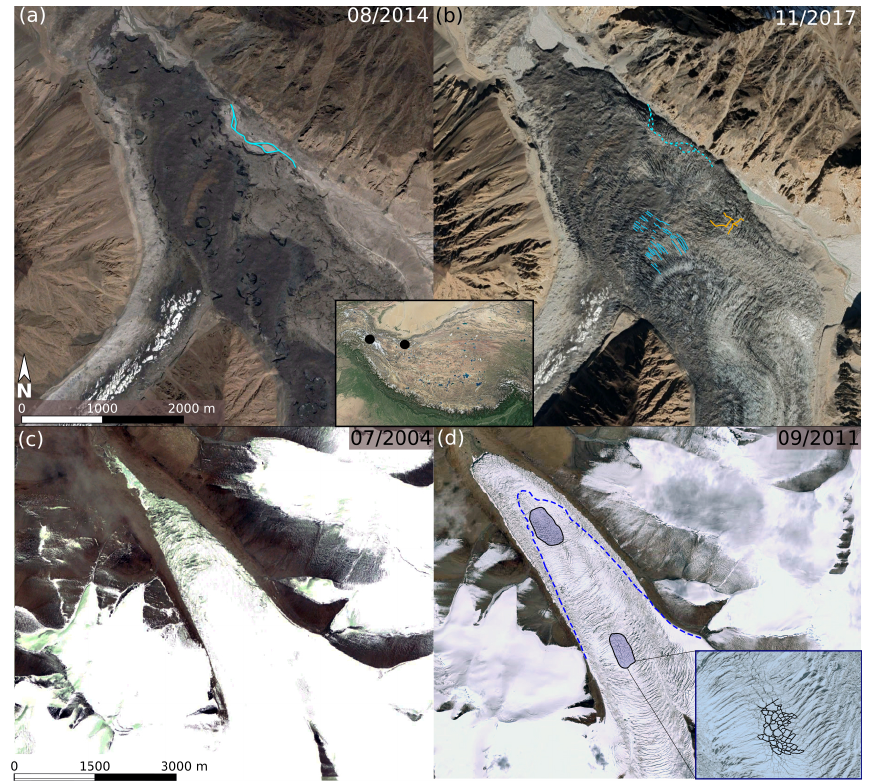
Figure 3. Google Earth imagery close-ups of surface features indicative of surges on debris-covered ( a, b : 2017 surge of Khurdopin Glacier, Hunza Basin, Karakoram) and clean ice glaciers ( c, d : 2008–2014 surge of N2 Glacier, West Kunlun Tibet, light blue). (a) Khurdopin Glacier in August 2014 during the quiescent phase. Note the abundance of supraglacial ponds on the stagnant ice. Blue line: river bed. (b) Khurdopin Glacier in November 2017 during the active phase (peaking in May 2017) (Steiner et al., 2018). The surface is heavily crevassed with longitudinal (blue lines) and intersecting crevasses (yellow). The blue dashed line represents the location of the river bed in panel (a) . (c) N2 glacier in a quiescent phase in 2004. (d) N2 Glacier in 2011 after active-phase peak (August 2009–November 2010) (Yasuda and Furuya, 2015). The blue dashed line represents the position of the glacier terminus in 2004. Note the substantial terminus advance and the two zones (blue polygons) of rhombic crevasse patterns, indicative of surge-type behaviour (Herzfeld and Zahner, 2001; Herzfeld et al., 2004). © Google Earth 2021 and ©